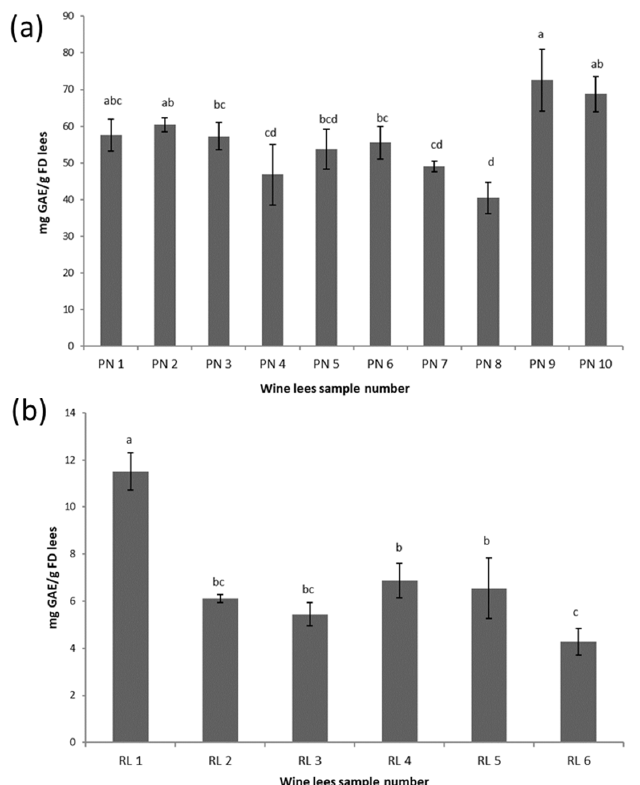
Figure 1. Total phenolic content (mg GAE/g DM lees) of PN ( a ) and RL ( b ) wine lees extracts. Samples that do not share the same letter (a–d) are significantly different ( p < 0.05). Error bars represent the standard deviation of replicate samples (n = 3).